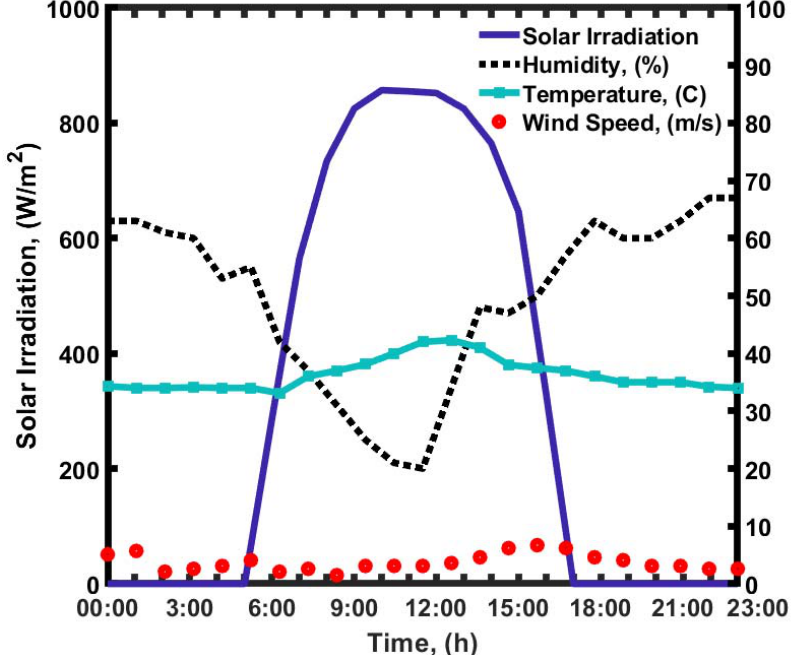
Figure 3 . 24-hour weather profile at Doha International Airport, Doha, Qatar (latitude: 25°17 ′ 9.9816 ″ N, longitude: 51°32 ′ 5.3412 ″ E).